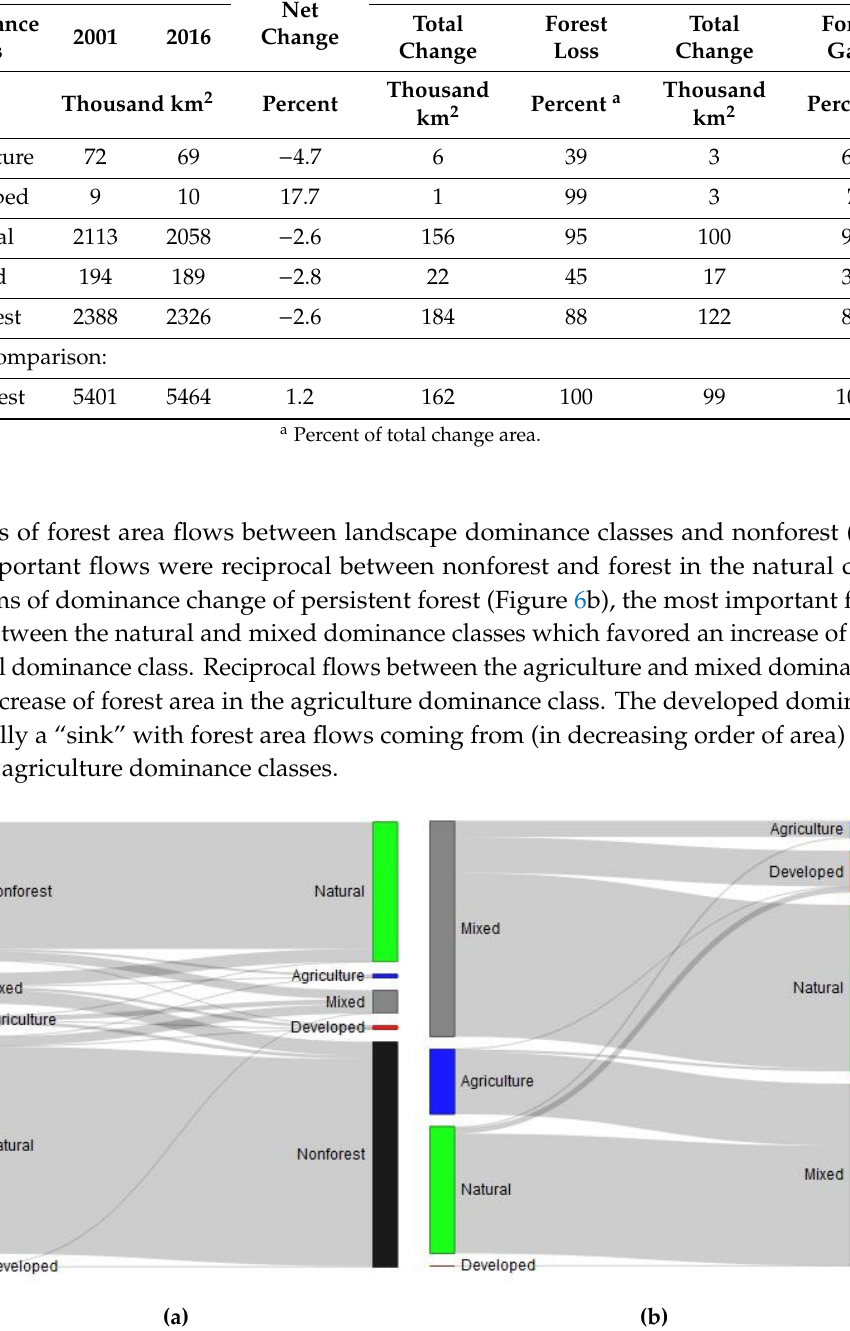
Figure 6. Flow diagrams of CONUS forest area change among dominance classes and nonforest, showing ( a ) total change and ( b ) the subset of change attributable to the shifting mosaic. The total area of all changes was 283,677 km 2 , and the total area of the shifting mosaic was 22,763 km 2 . Within each diagram, the flow is from 2001 ( left ) to 2016 ( right ). Flows less than 5 km 2 are not shown. Interactive versions of the flow diagrams are contained in supplemental material.